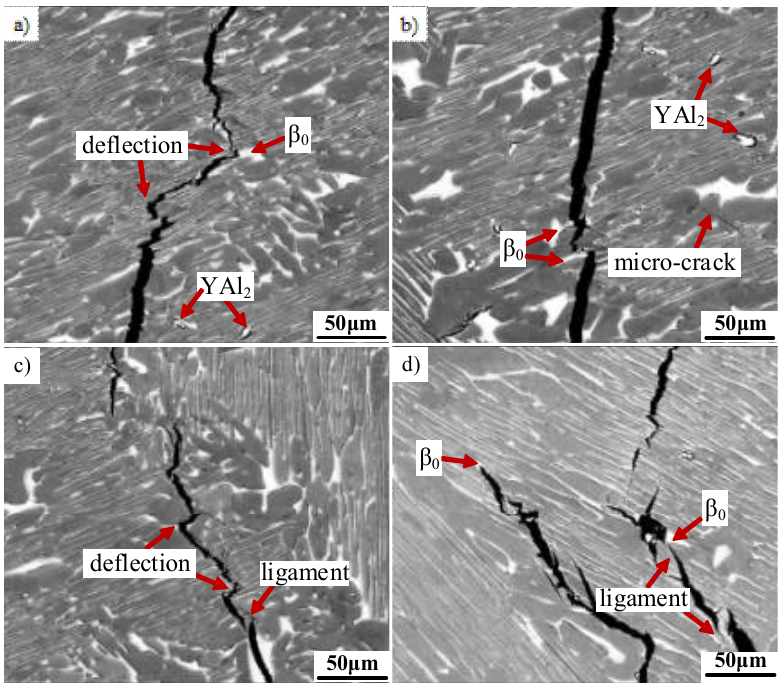
Figure 4. The effect of the β 0 phase on crack propagation in the as-cast TiAl alloy. ( a ) deflection, ( b ) YAl 2 , ( c ) deflection and ligament, ( d ) ligament.